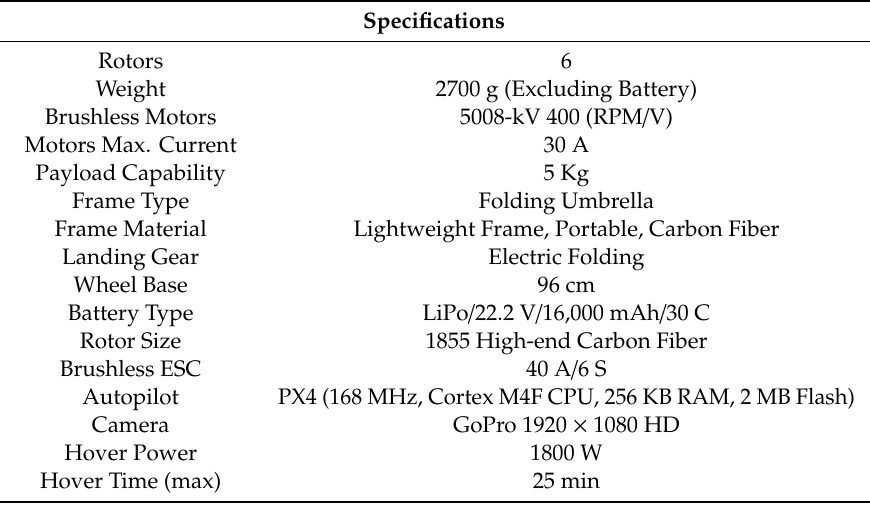
Table 1. Rescue UAV’s technical